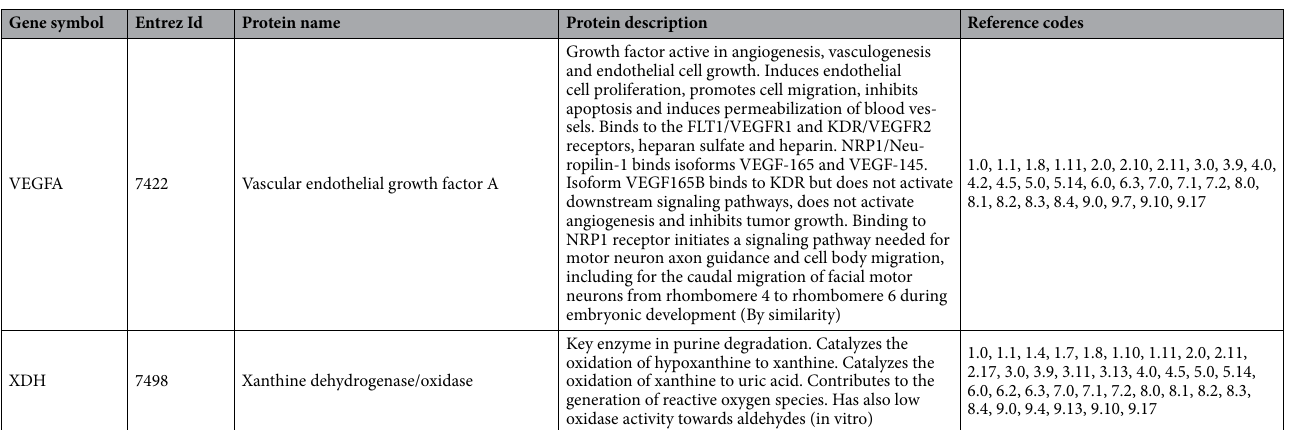
Growth factor active in angiogenesis, vasculogenesis and endothelial cell growth. Induces endothelial cell proliferation, promotes cell migration, inhibits apoptosis and induces permeabilization of blood ves- sels. Binds to the FLT1/VEGFR1 and KDR/VEGFR2 receptors, heparan sulfate and heparin. NRP1/Neu- ropilin-1 binds isoforms VEGF-165 and VEGF-145. Isoform VEGF165B binds to KDR but does not activate downstream signaling pathways, does not activate angiogenesis and inhibits tumor growth. Binding to NRP1 receptor initiates a signaling pathway needed for motor neuron axon guidance and cell body migration, including for the caudal migration of facial motor neurons from rhombomere 4 to rhombomere 6 during embryonic development (By similarity) Key enzyme in purine degradation. Catalyzes the oxidation of hypoxanthine to xanthine. Catalyzes the oxidation of xanthine to uric acid. Contributes to the generation of reactive oxygen species. Has also low oxidase activity towards aldehydes (in vitro) Table 2. Human proteins with both structural homology to SARS-CoV-2 proteins and associations with clinical indications.